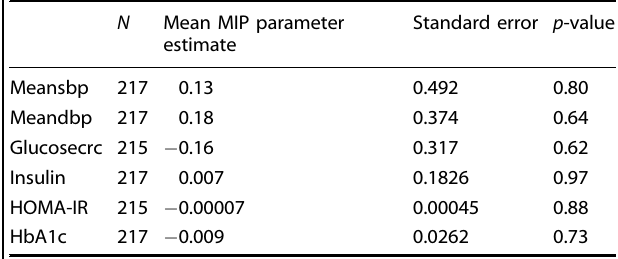
Table 4. Microbial indicator of periodontal disease (MIP) in saliva ( n = 282) is not correlated with markers of cardiometabolic health.